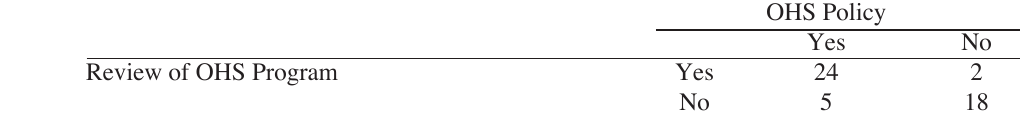
Cross-tabulation between Review of OHS Program and OHS Policy